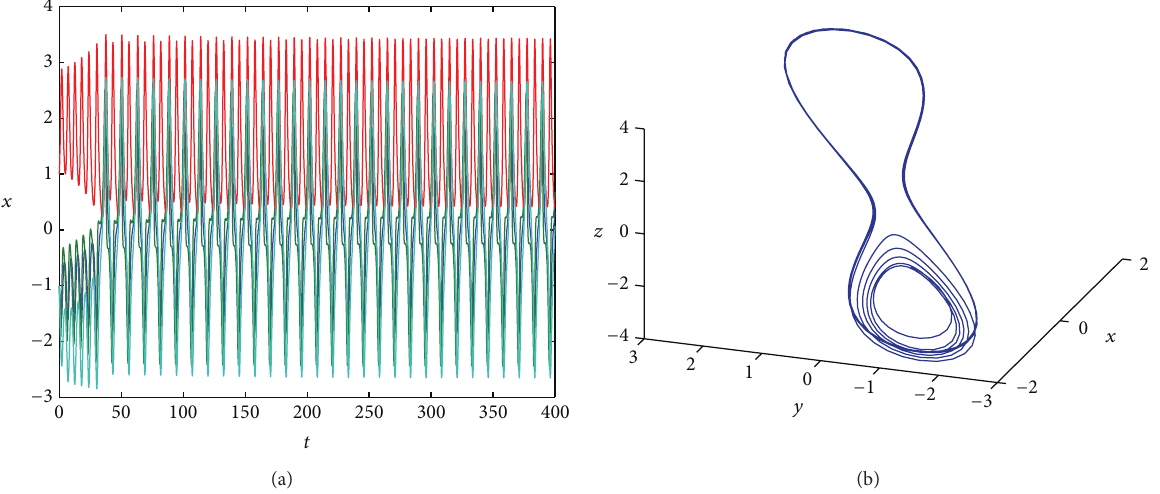
Figure 13: Time history and phase diagram of system (16) with 𝑎 = 1 , 𝑏 = 2 , 𝑚 = 0.5 , 𝑘 1 = 0.2 , 𝑘 2 = 0.5 , and 𝑐 = 0.65 .